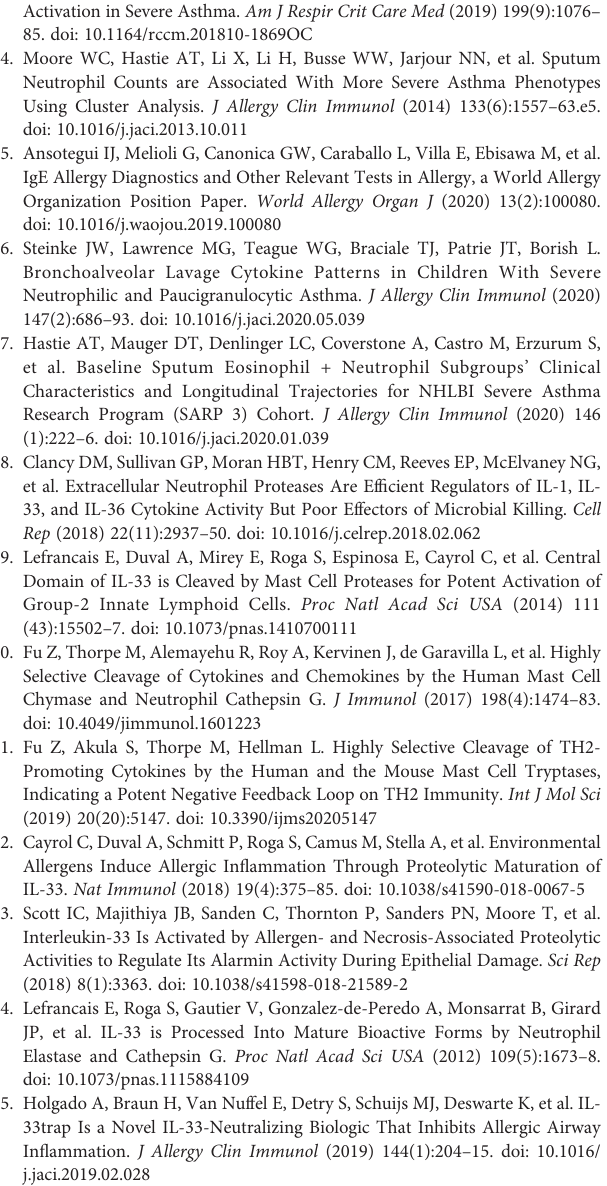
Supplementary Figure 2 | Gating strategyusedfor fl ow cytometryto analyze of eosinophils and neutrophils. First, the subset of viable cells isgated through